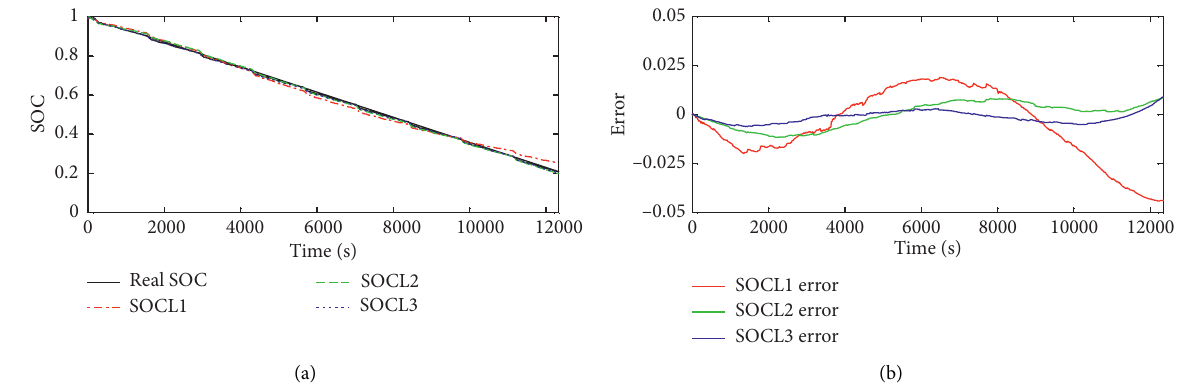
Figure 10: The SOC estimation results and errors of nRC models identified by the RLS method.